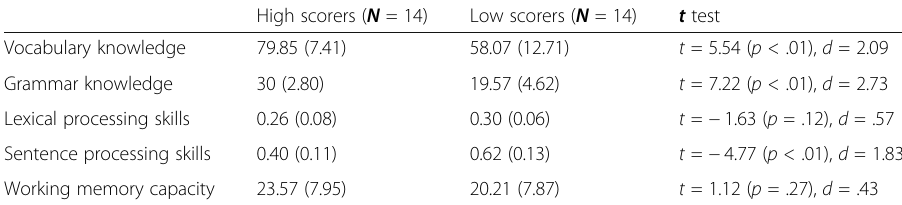
Table 4 The sub-reading abilities of each group